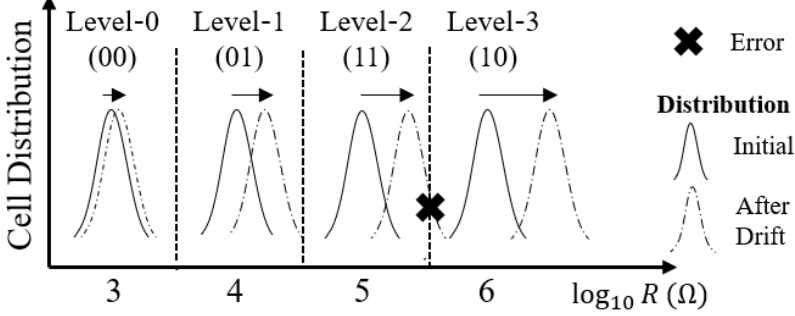
Figure 2. The highest error occurrence probability in Level-2 pattern by the resistance drift.